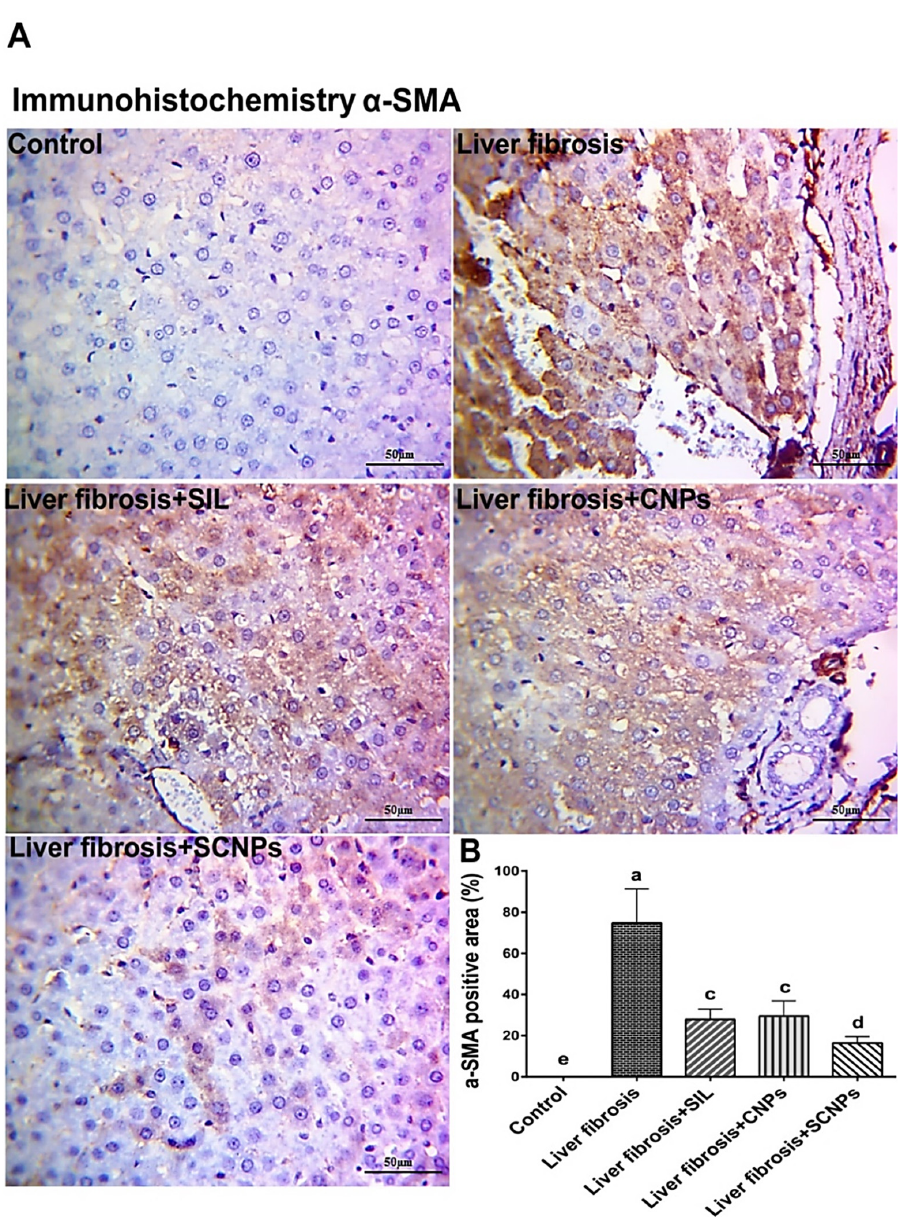
Figure 12. ( A ) α -SMA immunohistochemistry (IHC) staining in liver sections. The liver section